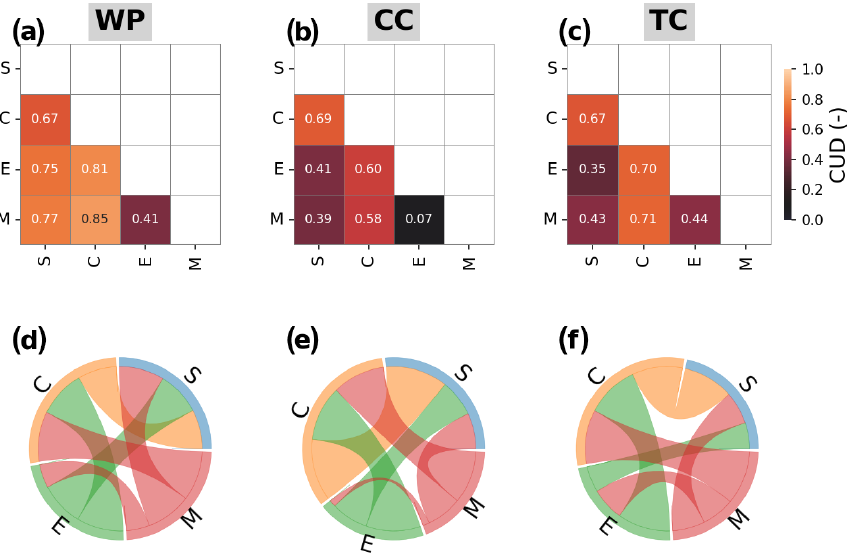
Figure 10. Clustering uncertainty degree (CUD) based on adjusted mutual information (AMI) between clustering results from different k -means algorithms, i.e., S, C, E, and M k -means, for different demo experiments: WP, CC, and TC. (a, b, c) CUD in heatmaps, (d, e, f) visualization of the interconnection using the chord diagrams. Note that the results are from the configuration with k = 4 and the first initialization